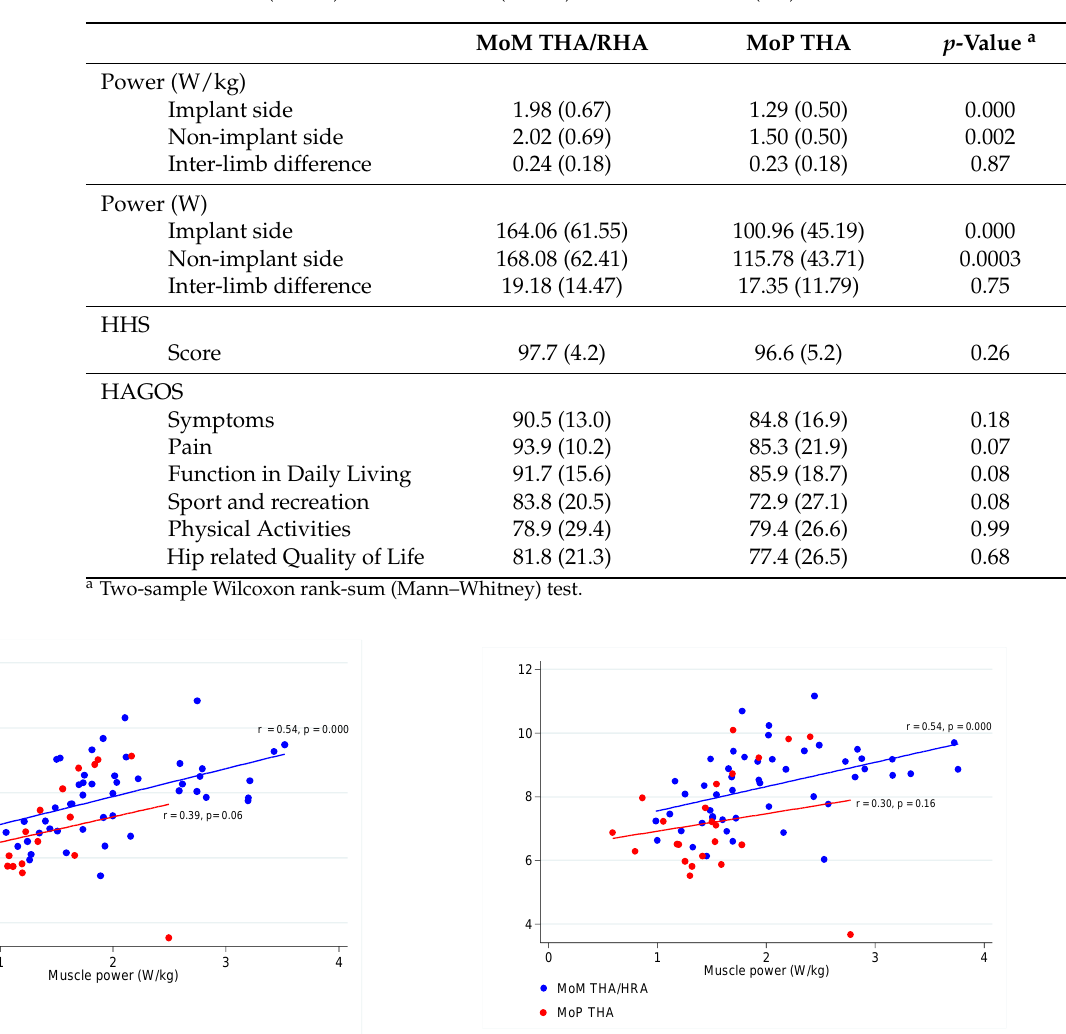
Table 3. Comparison of mean muscle power in both legs, inter-limb difference in mean muscle power, Harris Hip score (HHS), and the Copenhagen Hip and Groin Outcome Score (HAGOS) between MoM THA/RHA ( n = 50) and MoP THA ( n = 23). Values are mean (SD).